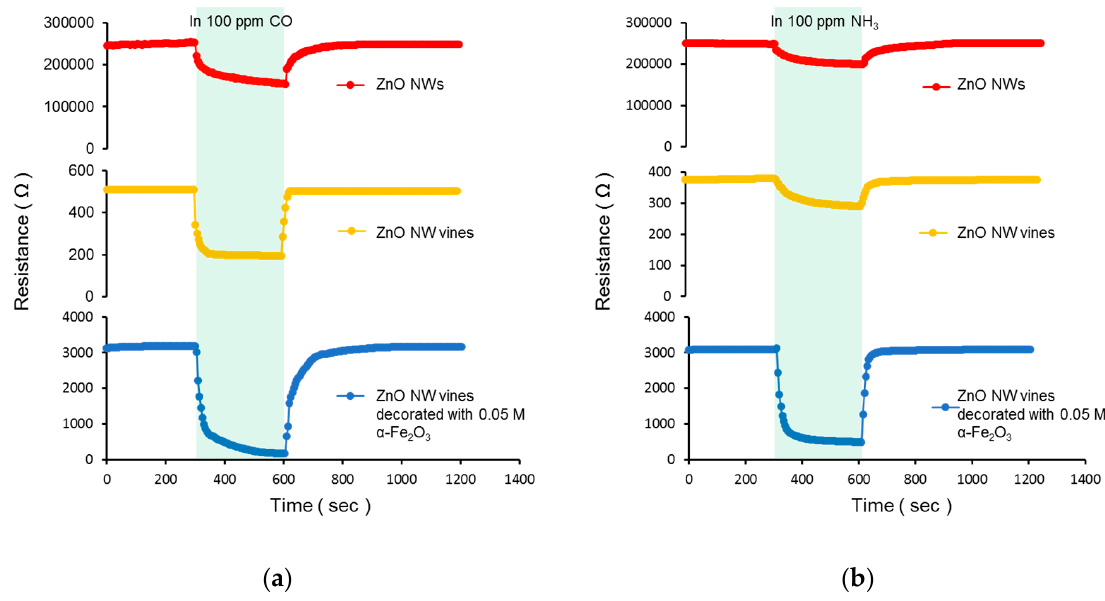
Figure 9. Resistance changes in ZnO NWs, ZnO NW vines, and ZnO NW vines decorated with 0.05 M α -Fe 2 O 3 to ( a ) 100 ppm CO and ( b ) 100 ppm NH 3 .